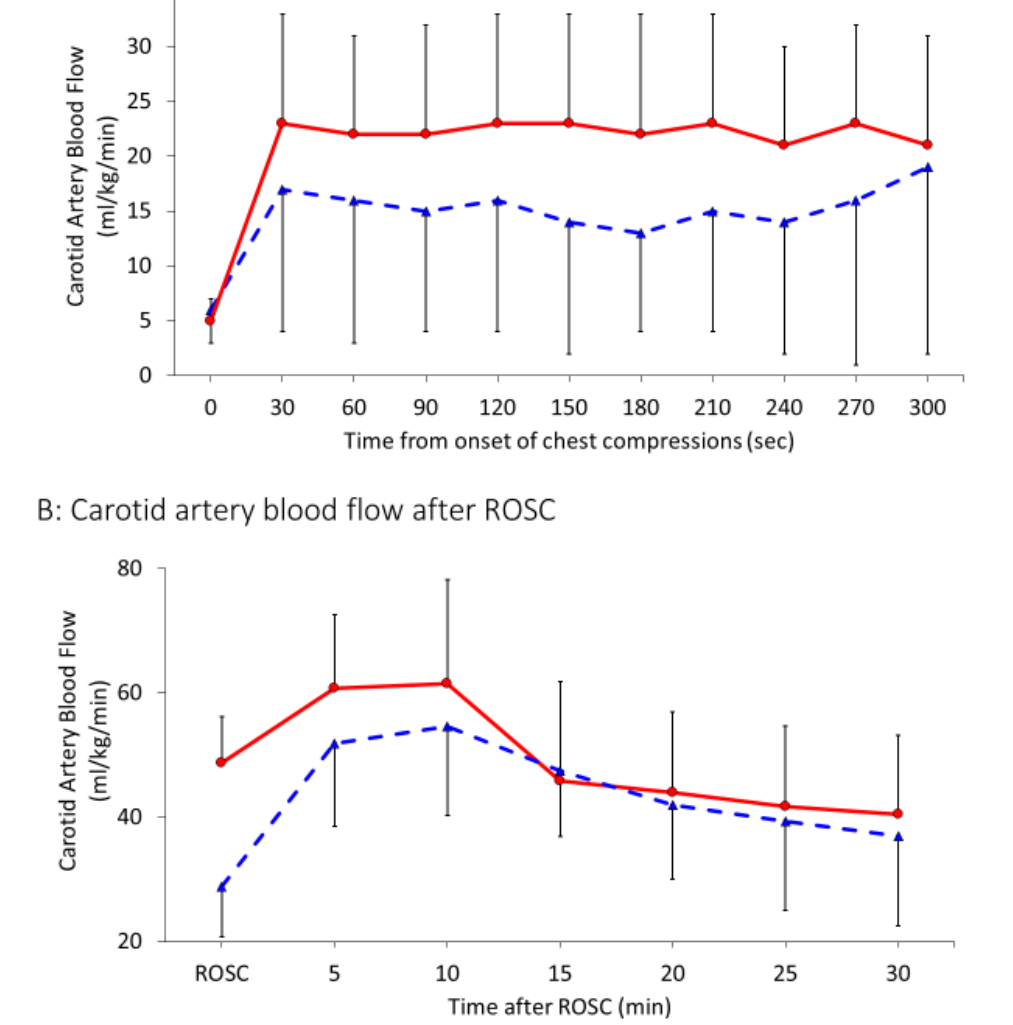
Figure 3. Interrupted line represents 21% and continuous line 100% oxygen. Data presented as average and standard deviation. ( A ) Carotid blood flow in mL/kg/min during CC. ( B ) Carotid blood flow in mL/kg/min after ROSC.